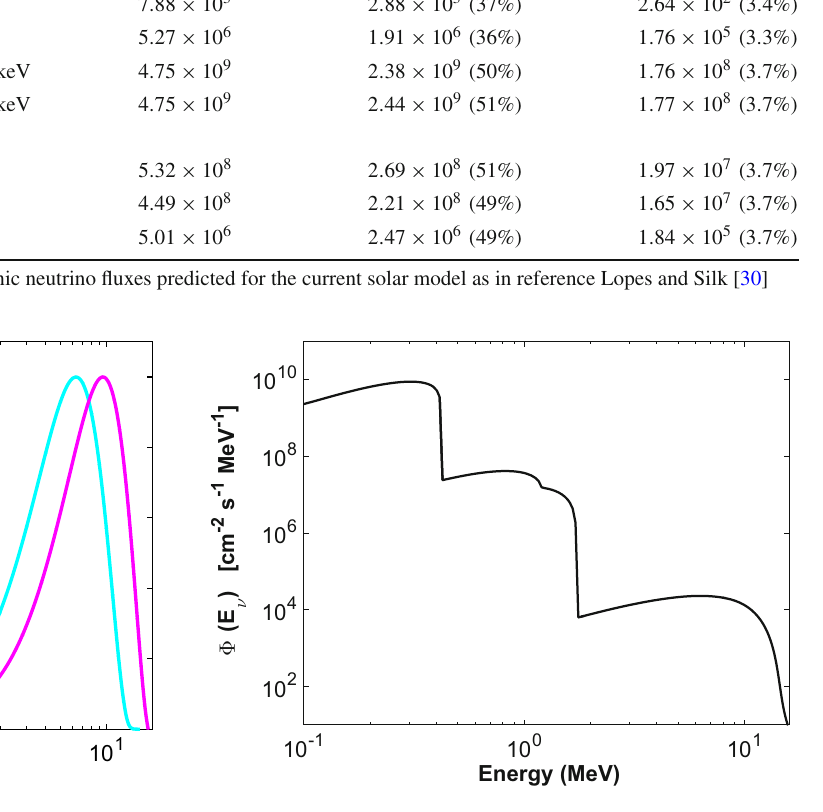
Fig. 11 The total sterile neutrino energy spectrum predicted by our standard solar model. The individual solar neutrino fluxes are shown in